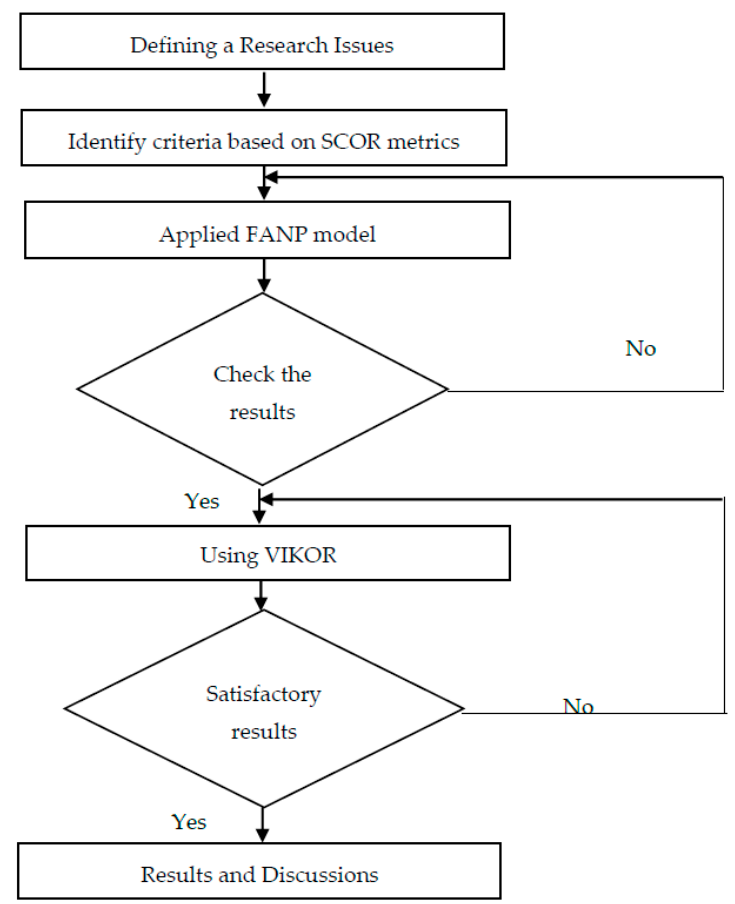
Figure 1. Research graph.